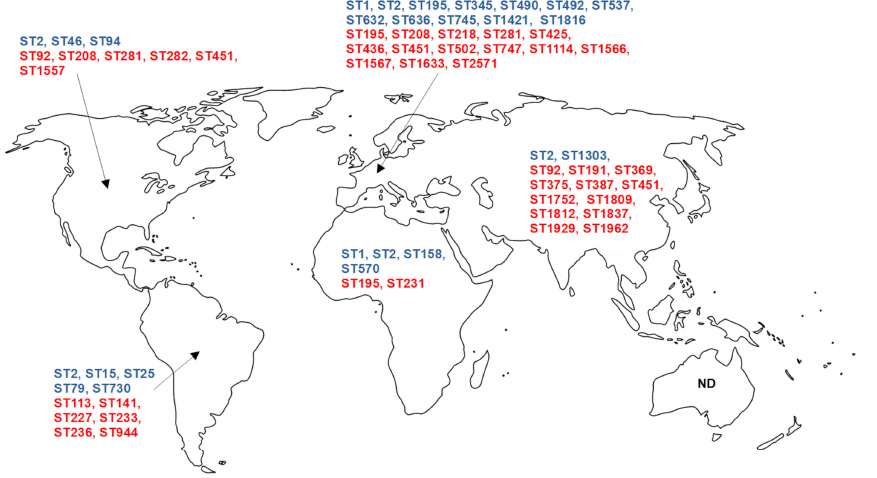
Figure 2. Global distribution of colistin-resistant A. baumannii STs according to published studies. Data for North America include the United States of America and Canada, while data for South America include data for the rest of the American continent. Pasteur MLST scheme—blue letters, Oxford MLST scheme—red letters. ND—no data available.